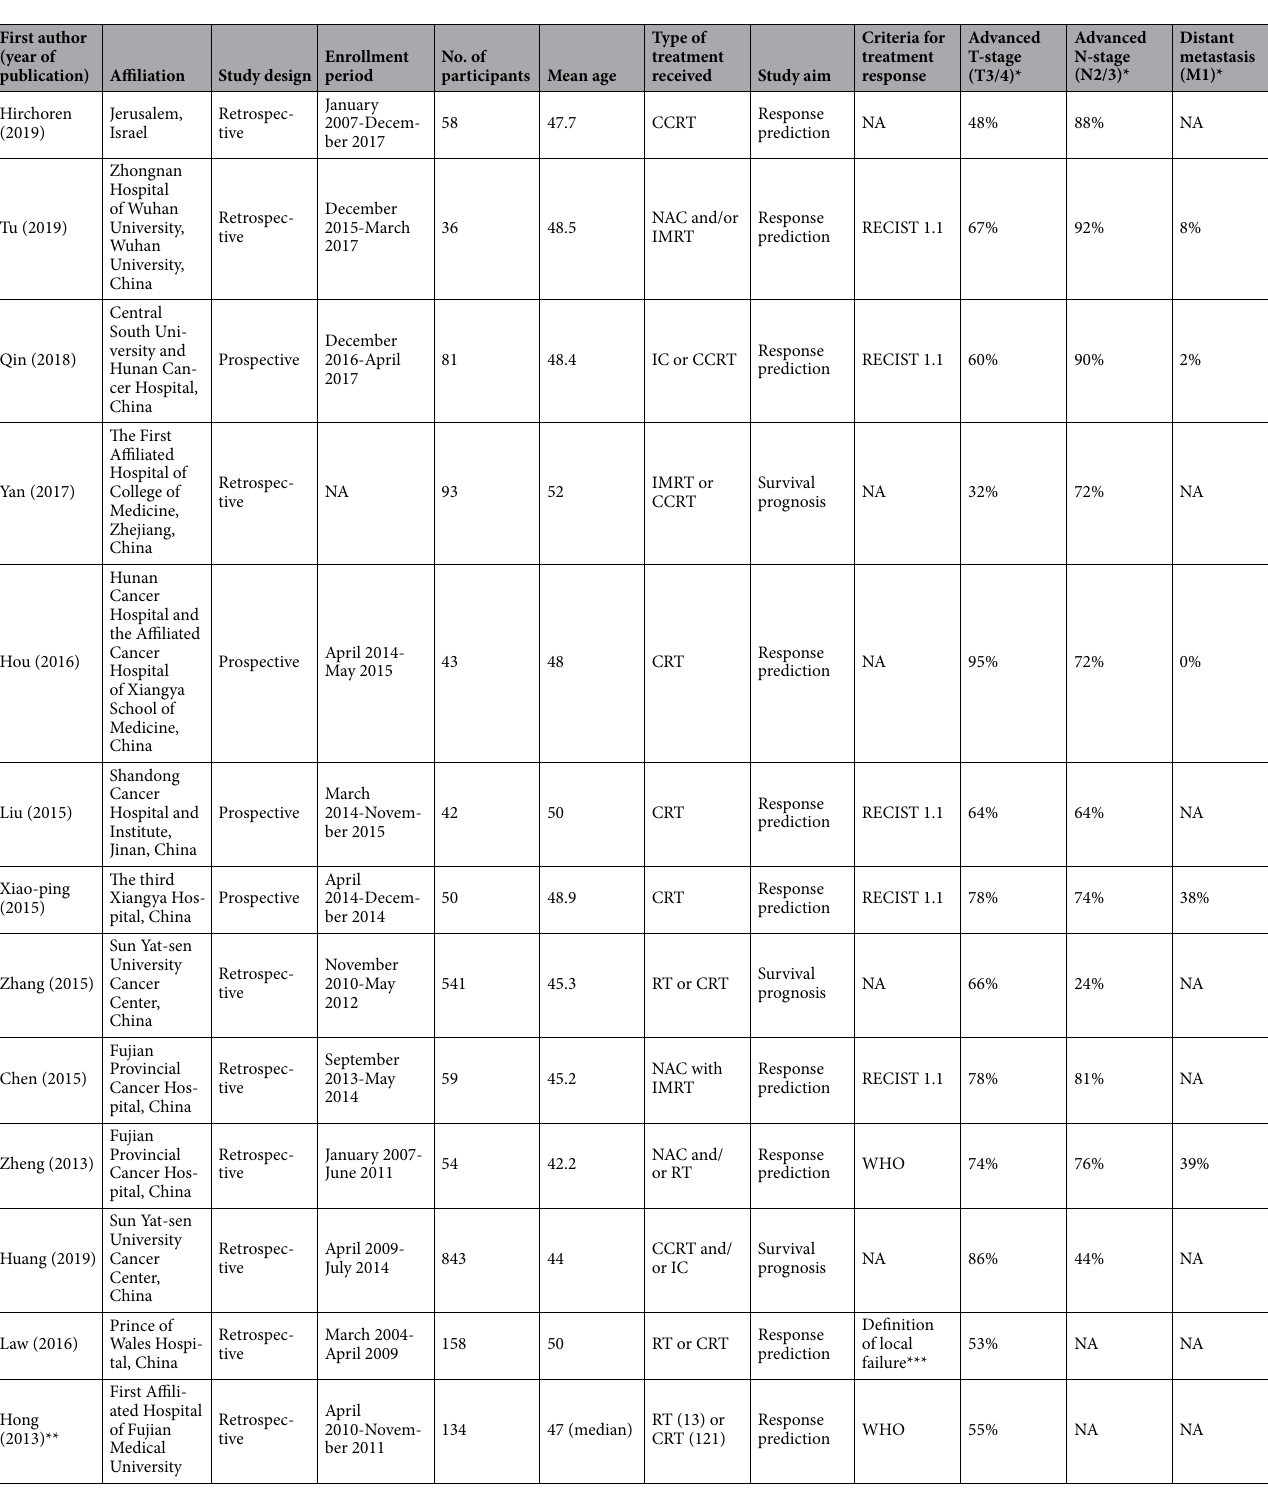
Table 1. The clinical characteristics of the included studies. CCRT, concurrent chemoradiation therapy; NAC, neoadjuvant chemotherapy; IMRT, intensity-modulated radiation therapy IC, induction chemotherapy; CRT, conformal radiation therapy; RT, radiation therapy; NA, not applicable. *Proportion of patients. **Not included in quantitative data synthesis. ***Defined as histologically positive or increase in tumor size on imaging or endoscopic